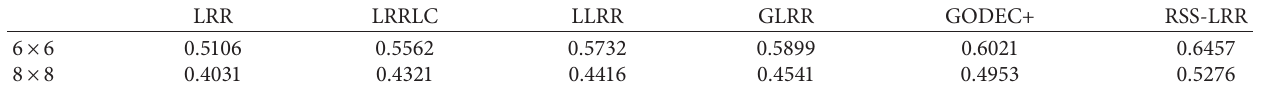
Table 9: Classification accuracies on LFW under 6 × 6 and 8 × 8 occlusions.